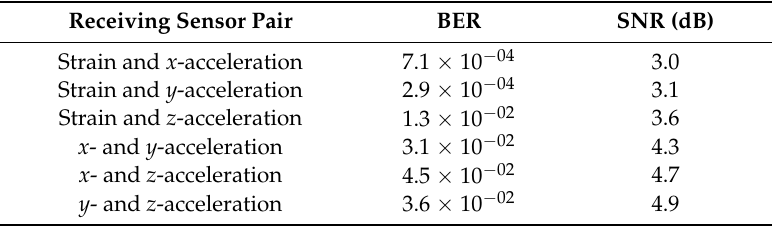
Table 2. Average BERs and SNRs of various receiving sensor pairs, with two actuators simultaneously transmitting two data streams.